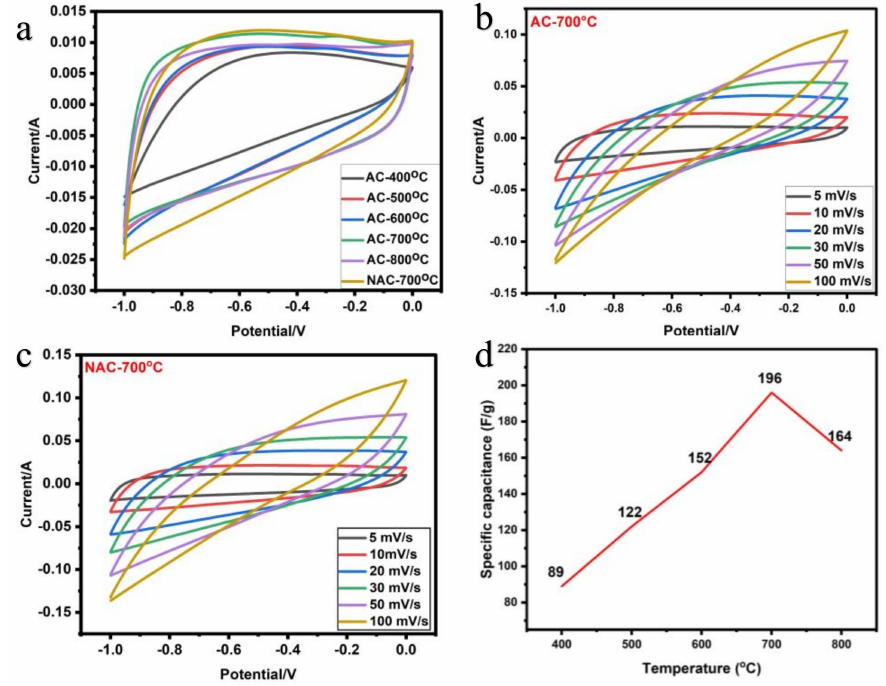
Figure 5. CV graph AC an NAC at various temperature ( a ) CV of AC and NAC at scan rate of 5 mV s − 1 , ( b ) CV curve of AC-700 ◦ C, ( c ) CV curve of NAC-700 ◦ C, ( d ) Effect of temperature on specific capacitance from